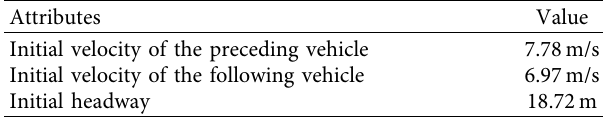
Table 4: Attributes setting of continuous traffic flow.